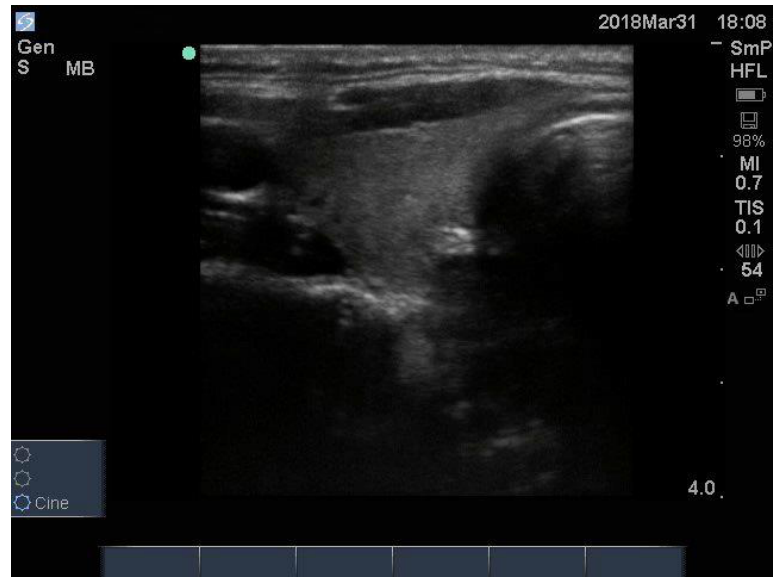
Figure 1. Right lobe of the thyroid gland of a 34-year-old female with no personal or family history of thyroid disease. The gland is of “normal size” and the t exture throughout is described as